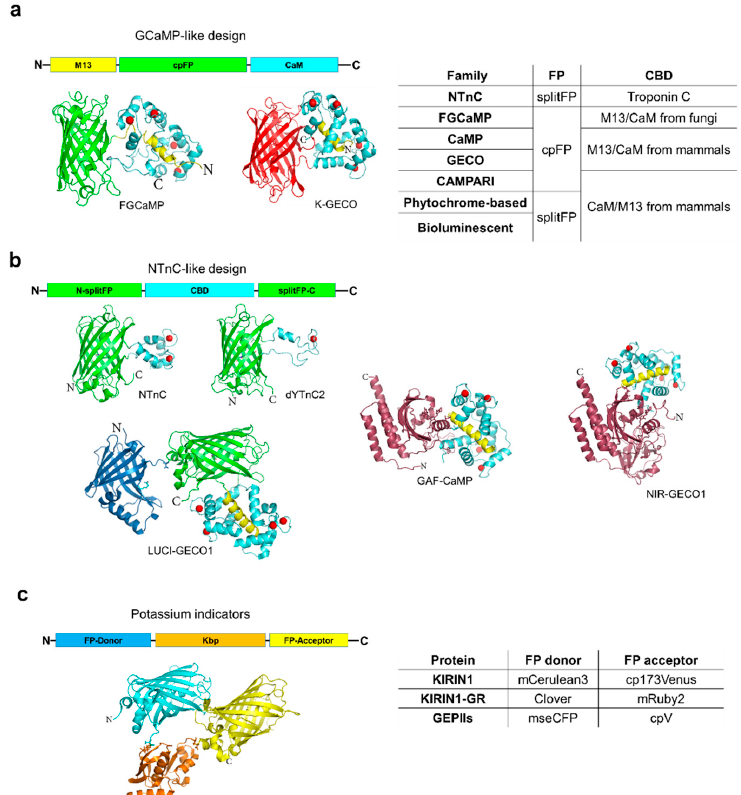
Figure 1. Molecular design of genetically-encoded calcium and potassium indicators. ( a , b ) The structure of calcium indicators are shown as ribbon diagrams according to the crystal structures of NTnC (protein database (PDB) 5MWC), dYTnC2 (unpublished), GAF-CaMP (combination of GAF-domain of PaBphP phytochrome PDB 3C2W and CaM/M13-peptide pair from GCaMP6m GECI PDB 3WLD), NIR-GECO1 (combination of the PAS-GAF domain of PaBphP phytochrome PDB 3C2W and CaM/M13-peptide pair from GCaMP6m GECI PDB 3WLD), LUCI-GECO1 (combination of NanoLuc luciferase PDB 5IBO and GCaMP6m GECI PDB 3WLD), FGCaMP (unpublished), and K-GECO (PDB 5UKG) in calcium-bound state. ( c ) The organization of potassium indicators is shown schematically and according to the X-ray structures of Cerulean and mVenus fluorescent proteins (PDB 5OXC and 1MYW, respectively), and Kbp potassium binding protein from E.coli (PDB 5FIM)